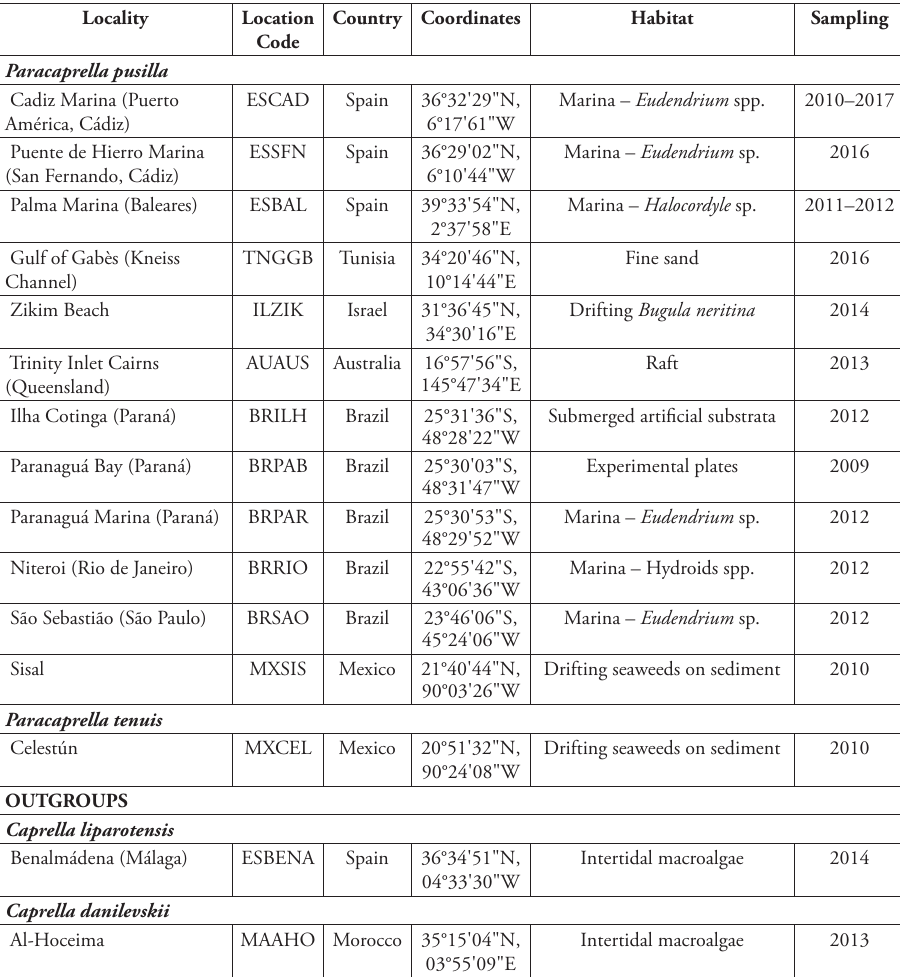
Table 1. Paracaprella pusilla sampling information. Sampling localities, location codes, source countries, geographical coordinates, substrata, and year of collection. Data for Cadiz Marina (ESCAD) correspond to the sample used in the spatial